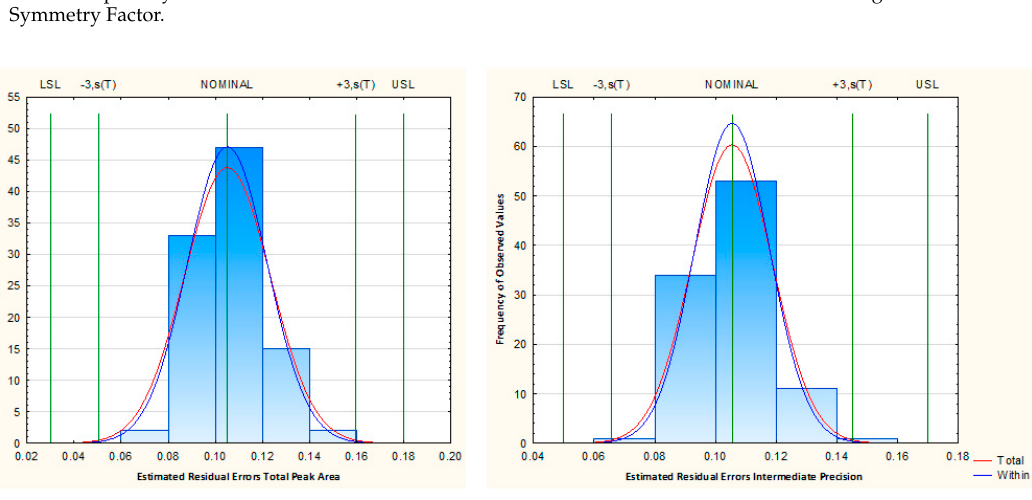
Table 3. Parameters results of the HS-SPME/GC-MS method for quantification of TMA and DMA in fish.